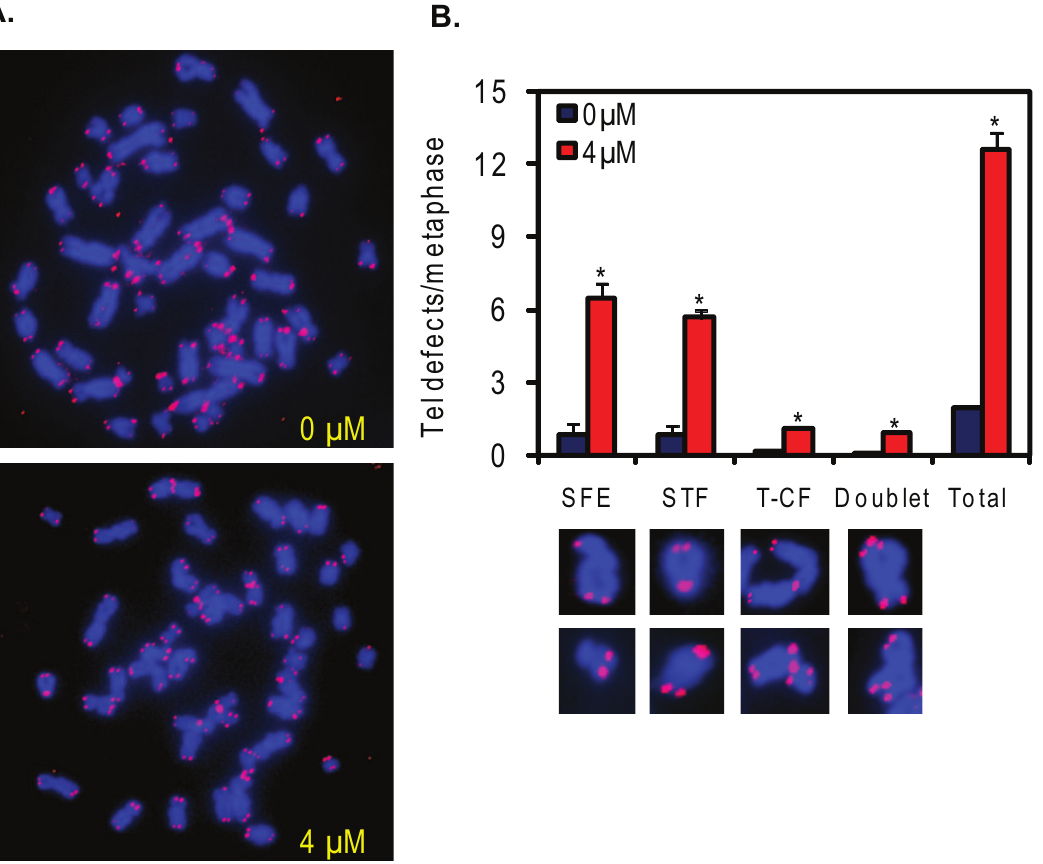
Figure 3. Cr(VI) induces telomere instability in lung fibroblasts. (A) Representative telomere FISH of full metaphases from cells exposed to the indicated Cr(VI) concentrations for 48 h and cultured in Cr(VI)-free medium for 10 h. (B) Cr(VI)-induced telomere instability. Approximately 60 metaphases from two independent experiments were analyzed to quantitate Cr(VI)-induced telomere defects. Bars with a symbol are significantly different from the untreated (p , 0.05). The data represent mean 6 SE from two independent experiments. Telomere signal free ends, SFEs; sister chromatid telomere fusions, STFs; chromosome/chromatid fusions with telomere signal at the fusion, T-CF.